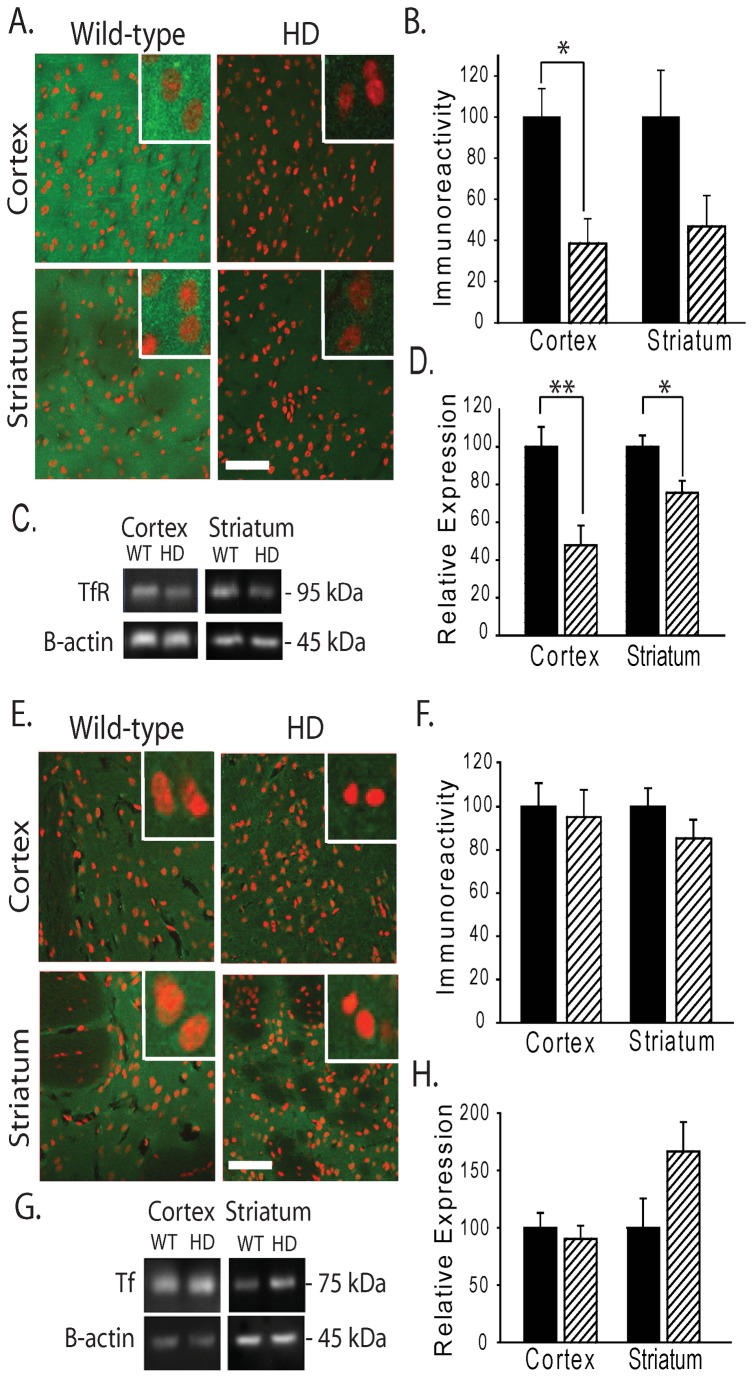
Decreased expression of transferrin receptor (TfR) but not transferrin (Tf) in R6/2 HD mice.Analysis of TfR (A-D) and Tf (E-H) protein expression in brain. A. Representative images indicate decreased TfR immunoreactivity in HD TG cortex and striatum as compared to wild-type mice at 12-weeks of age. (Red, DRAQ5 stain; Green, TfR). Bar = 50 μm. Inserts = 20 μm. B. Quantification of neuronal cell body TfR immunoreactivity in cortex and striatum of wild-type and R6/2 mice. C-D. Western blot analysis of TfR detects a band migrating at ~95 kDa consistent with TfR (C); this band is significantly decreased in HD as compared to wild-type mice in cortex and striatum (D). E. Representative images of Tf immunofluorescence in HD and wild-type litter-mate mice. F. Quantification of Tf immunoreactivity. G-H. Western blot analysis of Tf detects a band migrating at ~75 kDa consistent with Tf (G); there is no change in protein levels in HD mice (H). P-values: *<0.05, **< 0.01, n=3-4 for immunofluorescence analyses and n=9-10 for Western blot analyses.